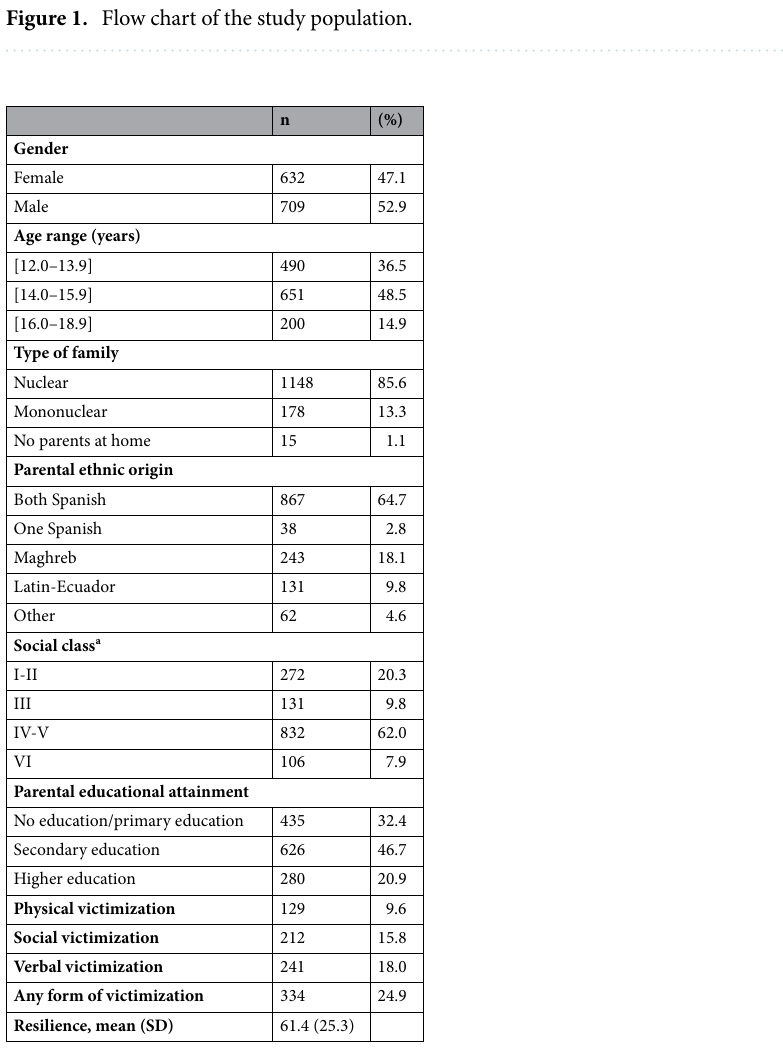
Table 1. Demographic characteristics, resilience and prevalence of peer victimization among adolescents (n = 1341). Population’s total number (n) and percentages (%) according to sociodemographic characteristics. SD: Standard deviation. a. Social class: I. Higher managerial; II. Intermediate managerial; III. Supervisory and junior managerial; IV. Skilled manual occupations; V. Unskilled manual occupations; VI. Unemployed/